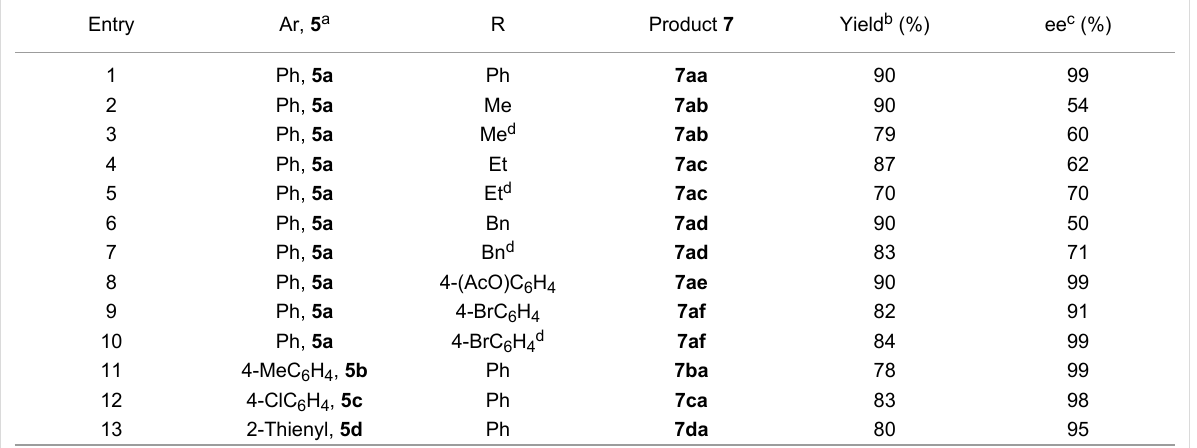
Table 2: 1,3-Dipolar cycloaddition of azlactones 5a with